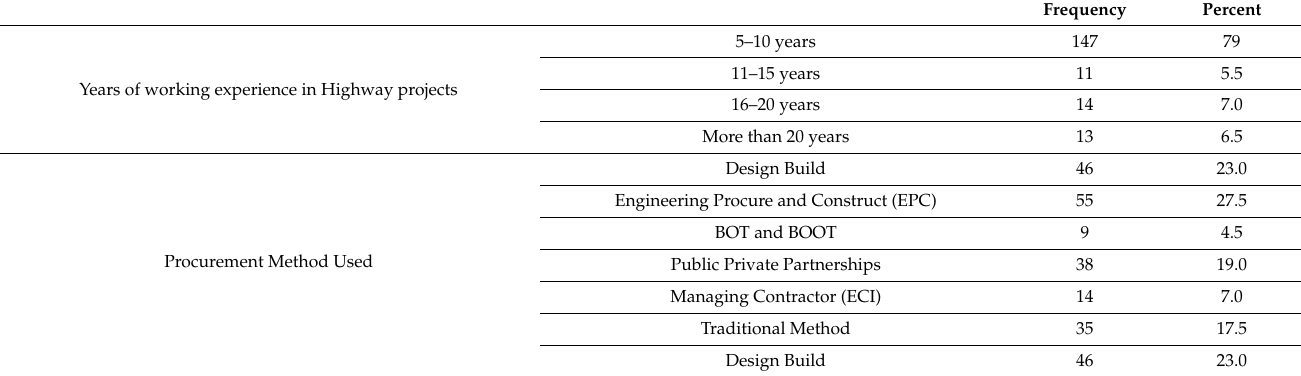
Table 1. The demographic profile of